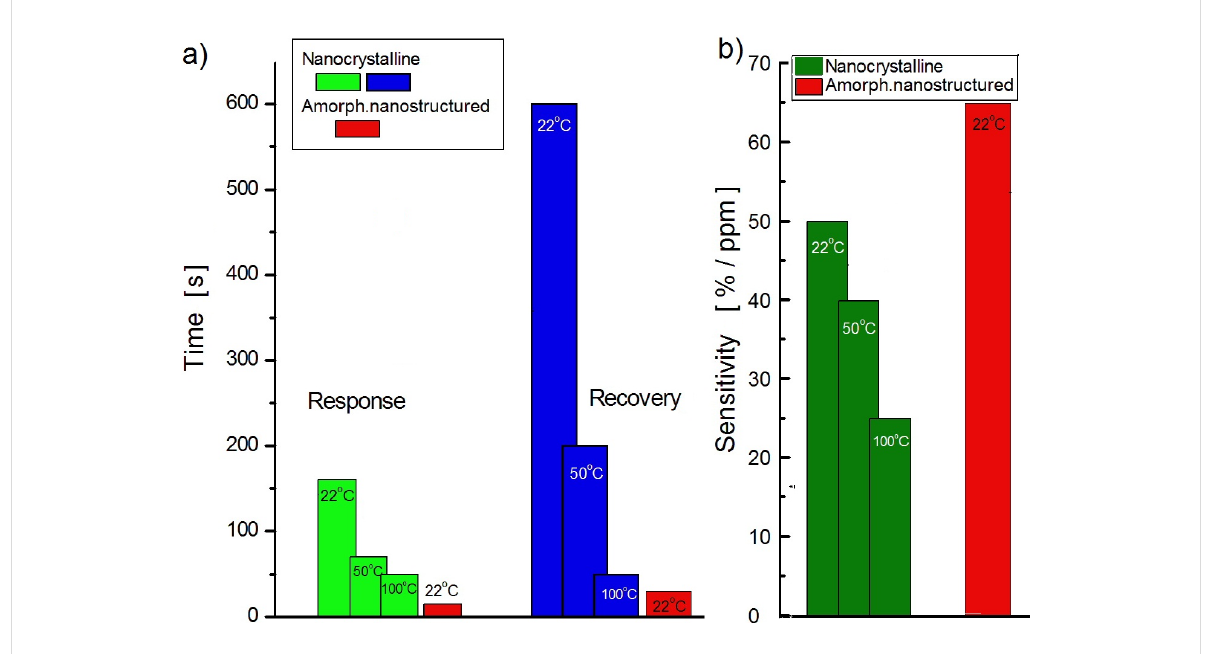
Figure 6: Comparison of the gas-sensing properties of nanocrystalline and amorphous nanostructured Te-based films to NO 2 at different tempera- tures: A) response and recovery times; B) sensitivity.